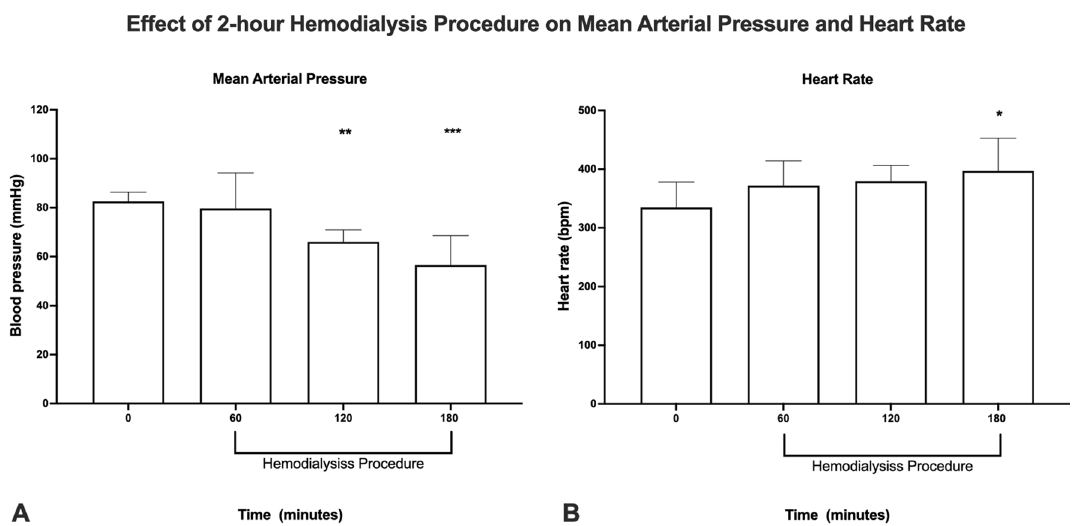
Figure 6. Effect of total experimental hemodialysis procedure on: ( A ) mean arterial pressure and ( B ) heart rate. Hemodialysis started following the sham procedure (timepoint 60 min) and recorded continuously during the 2-h hemodialysis. (n = 9 animals; Ordinary one-way Anova with Dunnet correction for multiple comparisons; (*): p < 0.05, (**): p < 0.01), (***): p < 0.00. (Image produced by B(GH) Janssen using; Prism 9 for macOS (Version 9.2.0 (283), GraphPad Software, San Diego, California USA, http:// www. graph pad.